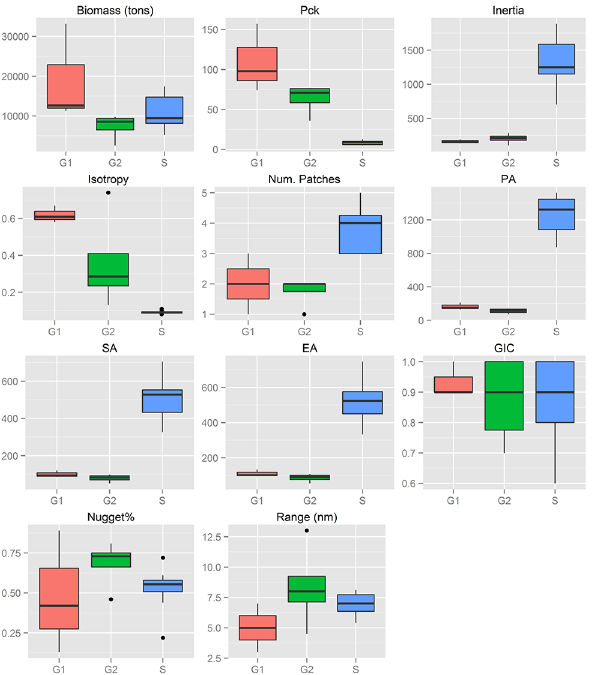
Fig 7. Sardine: Box-plots of biomass (t), packing density (Pck) and spatial indicator values per sub- area. See Table 1 for descriptions of abbreviations. S1: Adventure Bank sector in Sicilian waters, S2 Maltese Bank sector in Sicilian waters, G1: Thermaikos Gulf, G2: Thracian Sea.